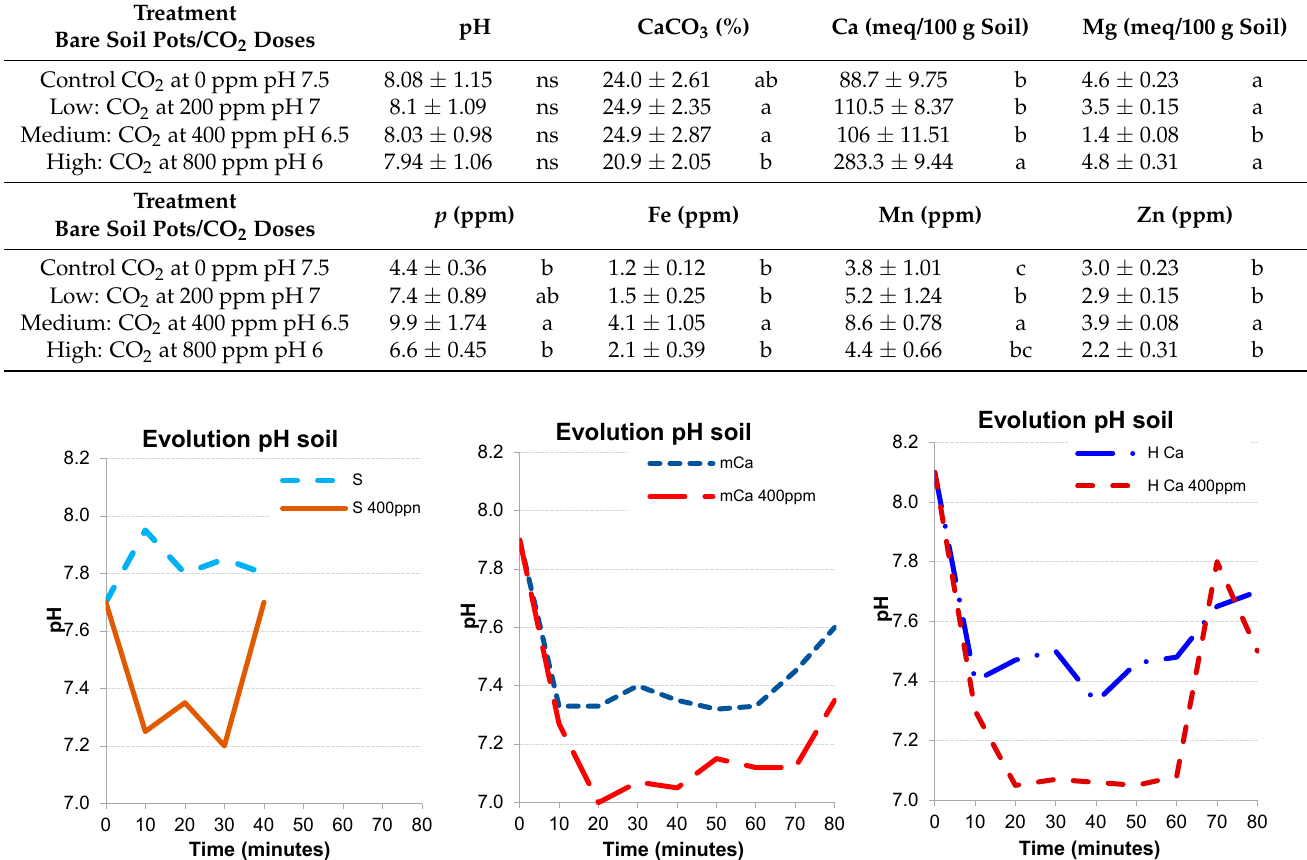
Table 3. Experiment 1. Bare soil pots. Quantitation of soil pH, carbonates, and mineral composition in a Medium calcareous soil with 10.4% limestone, pH 8.08, and 24.03% CaCO 3 . Soil samples were taken after irrigation for 4 months. Different carbonated irrigation treatments: control (tap water pH 7.5), CO 2 at 200 ppm (pH 7), CO 2 at 400 ppm (pH 6.5), and CO 2 at 800 ppm (pH 6). Values with